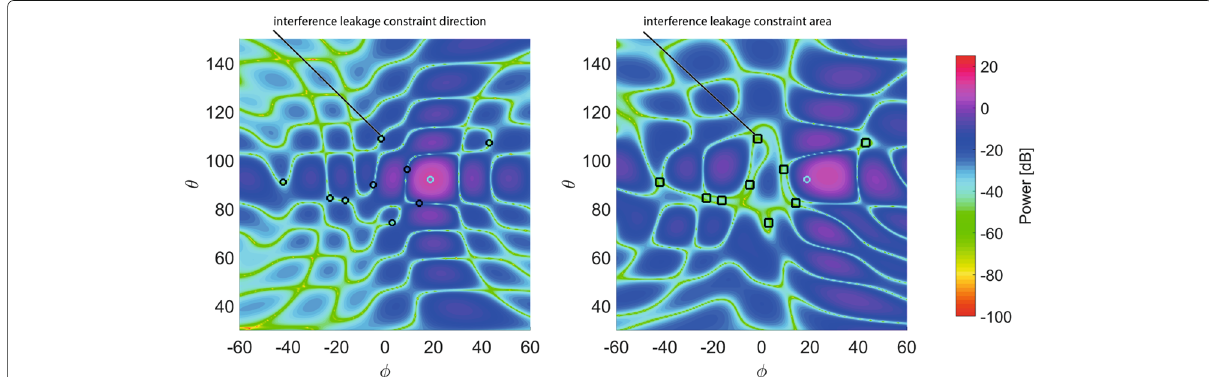
Fig. 2 Radiation beam pattern obtained with non-robust leakage-bounded angular beamforming (left) and with robust leakage-bounded angular beamforming (right). The nine angular uncertainty regions of robust leakage-bounded angular beamforming have a width of ψ max = ± 1.6 ◦ in this